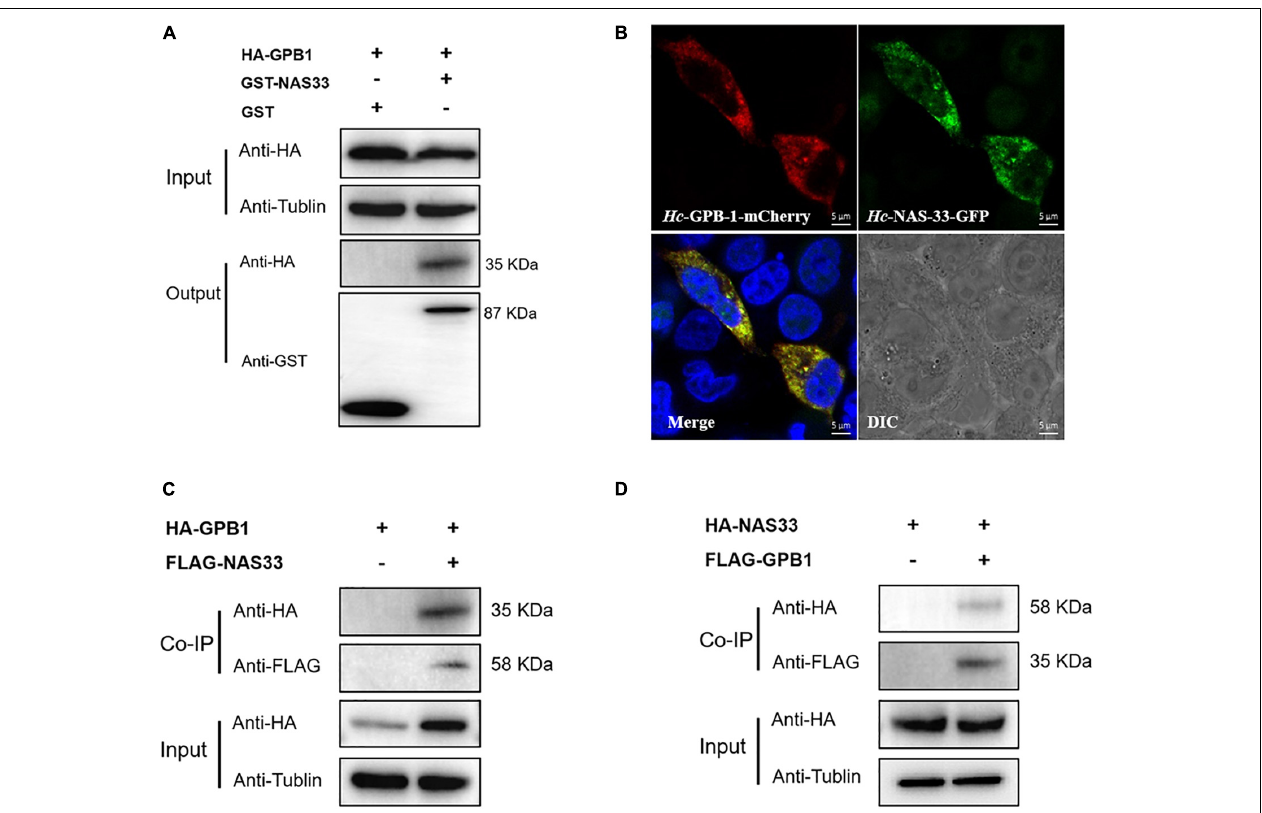
FIGURE 4 | Hc -NAS-33 interacts with Hc -GPB-1 in vitro and in vivo . (A) Pull-down assay showing the interaction of Hc -NAS-33 and Hc -GPB-1. (B) Co-localization of Hc -NAS-33 and Hc -GPB-1 in HEK 293T cells. Scale bar: 5 µ m. (C,D) Co-IP assay verifying the interaction of Hc -NAS-33 and Hc -GPB-1 in vivo .